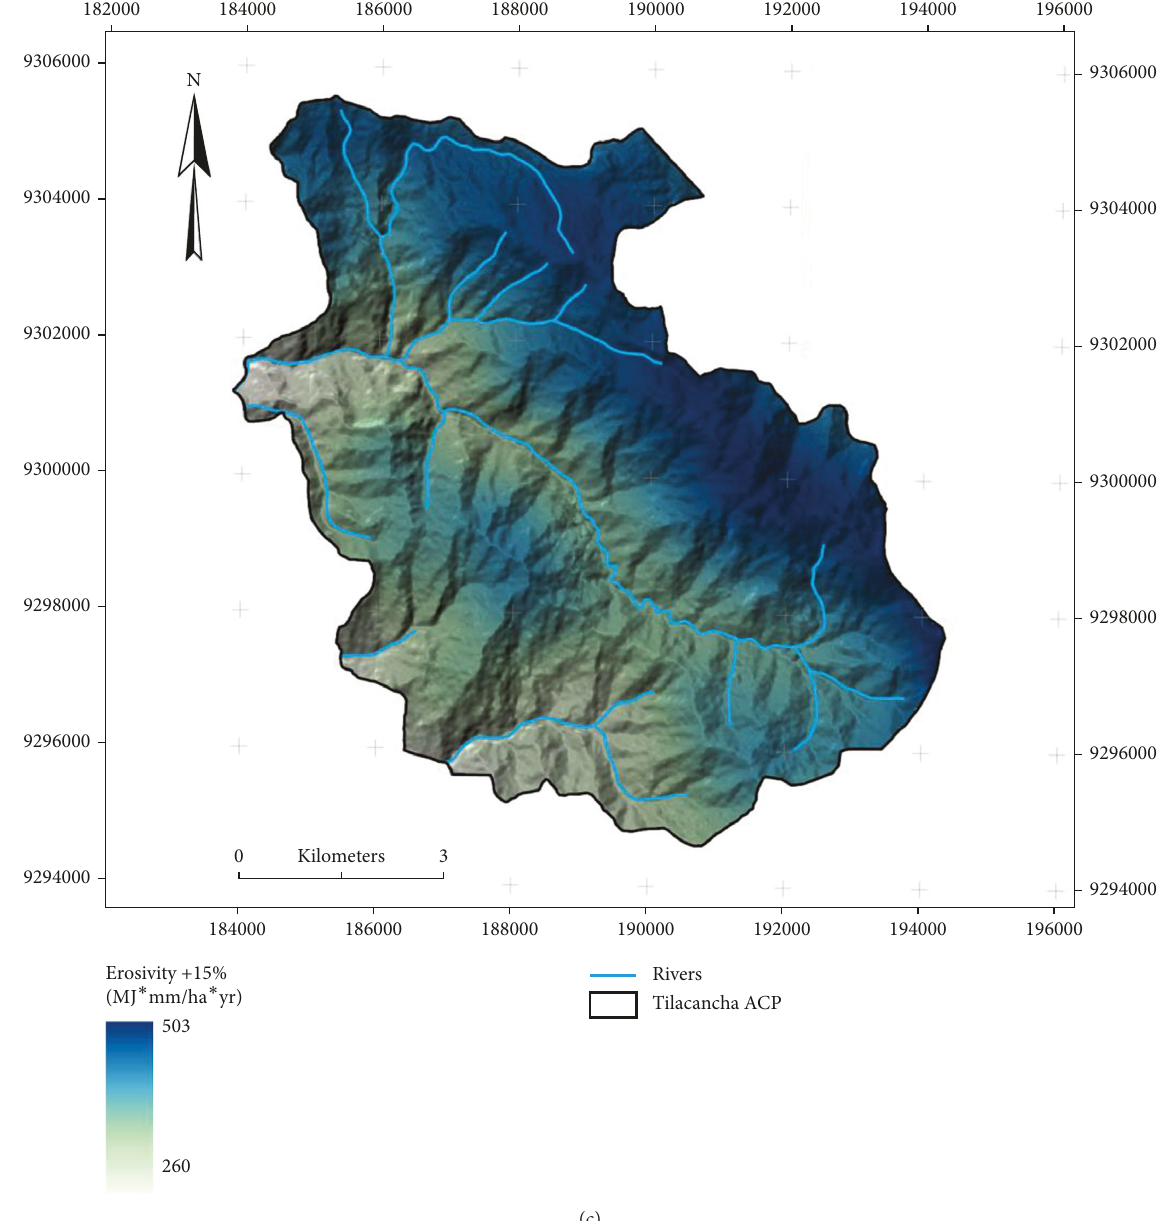
Figure 7: Methodological flow for the simulation under two scenarios of soil loss due to water erosion for values of the R factor (erosivity), in the Tilacancha ACP, where factor A is the average annual soil loss in the Tilacancha ACP in